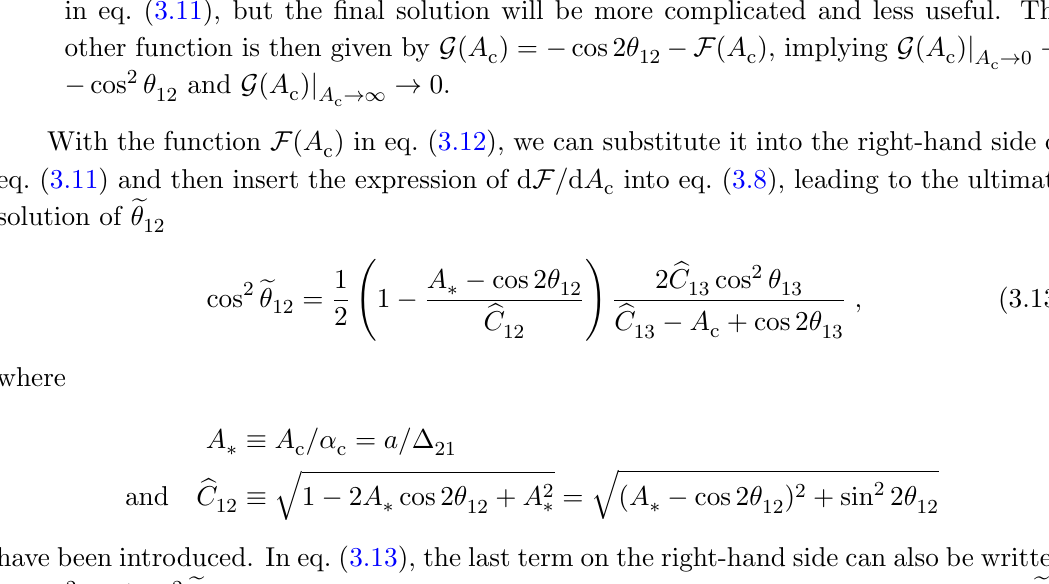
Figure 2 . Left panel : analytical and numerical solutions to e (cid:18) mass ordering, where the input parameters are the same as in (cid:12)gure 1. For the analytical solutions, the approximate result in eq. (3.14) has been plotted as the red dotted-dashed curve, while the full result in eq. (3.13) as the red solid curve. Right panel : the di(cid:11)erence (cid:1) e (cid:18) in eq. (3.13) and the numerical result is plotted as the red curve for neutrinos while the blue one for